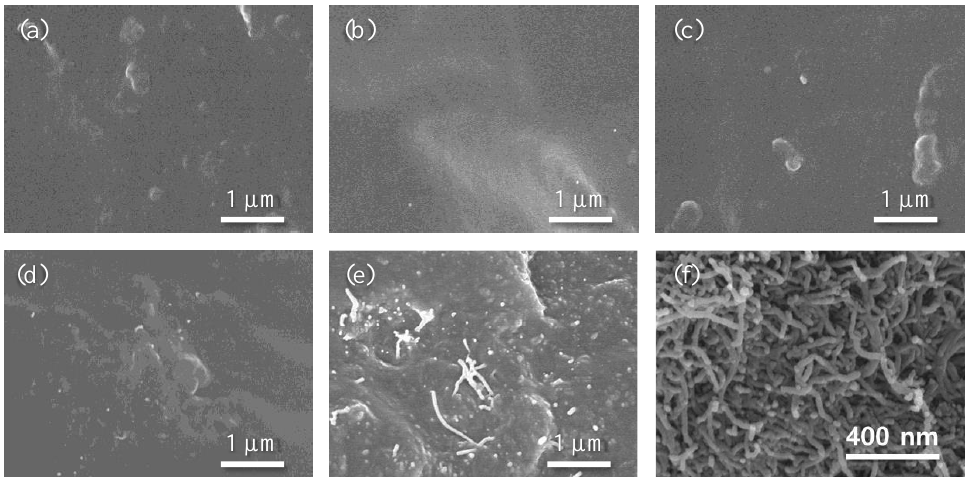
Figure 2. SEM images of MWCNT/PDMS composites of ( a ) 0.01, ( b ) 0.05, ( c ) 0.1, ( d ) 1, and ( e ) 10 wt% MWCNT. ( f ) SEM image of as-received MWCNT.